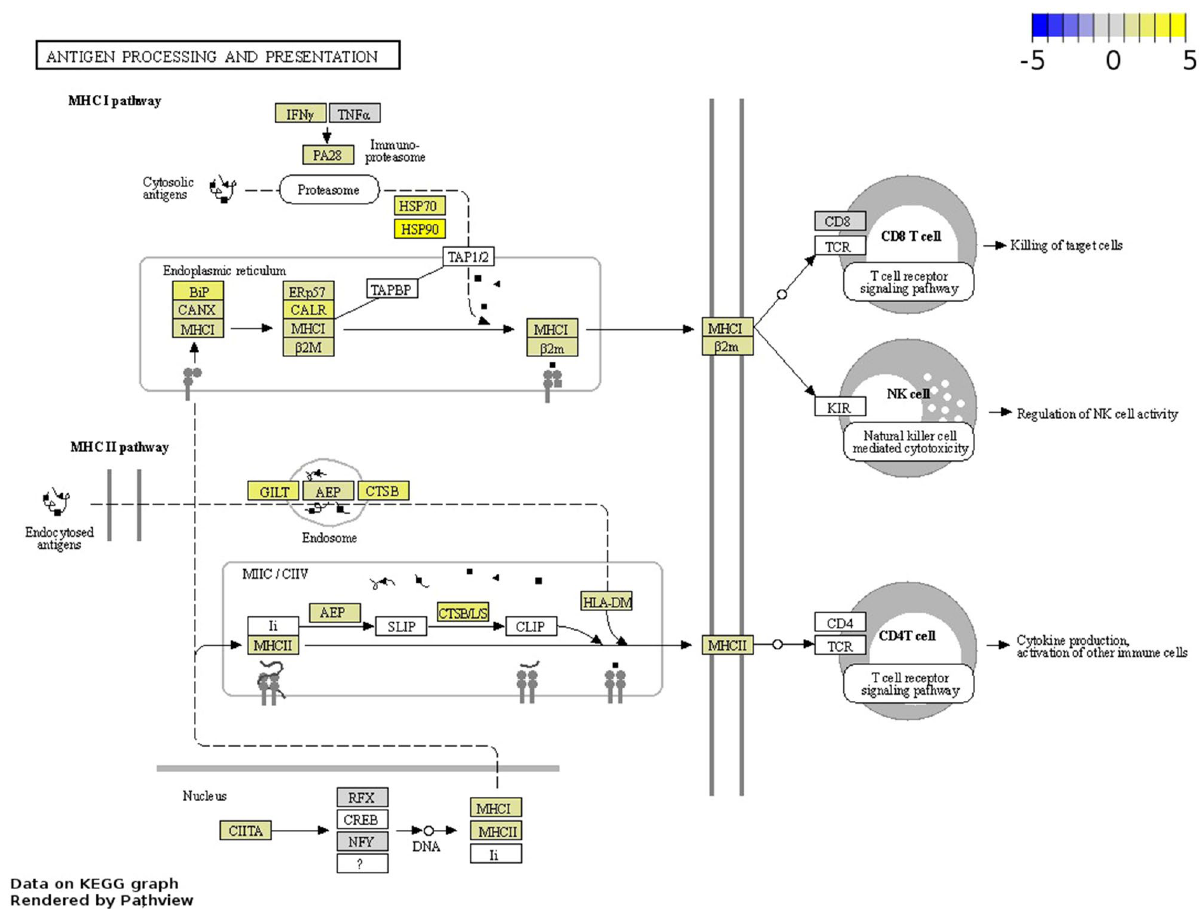
Figure 4. Upregulated genes enriching the Antigen Processing and Presentation pathway (fca04612) in basal- like triple-negative tumours. Gene log 2 fold change relative to controls is indicated in yellow (upregulated) or blue (downregulated), white boxes represent genes not detected. Data on KEGG graph rendered by “Pathview” (https:// pathv iew. uncc.